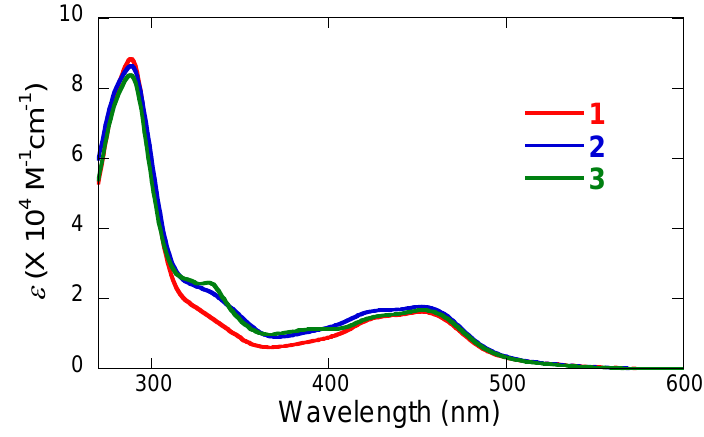
Figure 1. Absorption spectra of [ 1 ](PF [ 3 ](PF ) ·2H O (green line) in DMF at 20 °C in air. 6 2 2